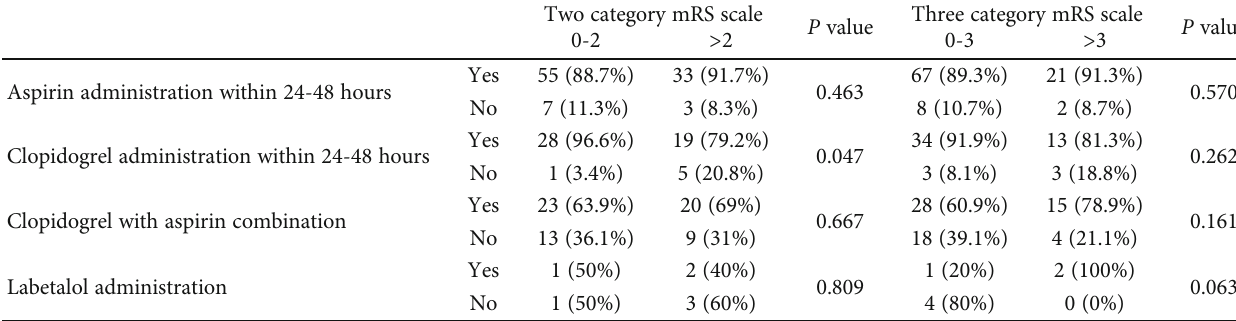
Table 4: E ff ects of antiplatelet and antihypertensive medications on mRS at discharge.